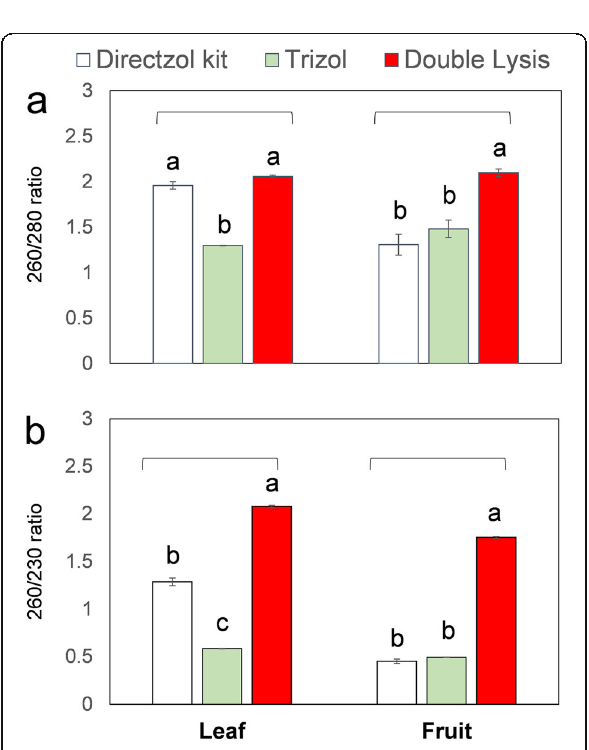
Fig. 4 Purity of RNA isolated from strawberry leaves (left) and fruits (right) assayed spectrophotometrically. a A 260 / A 280 ratio b A 260 / A 230 ratio. Values represent means ± SE of three independent biological replications. Means with the same letters are not significantly different according to Tukey ’ s honest significant (HSD) test ( p ≤